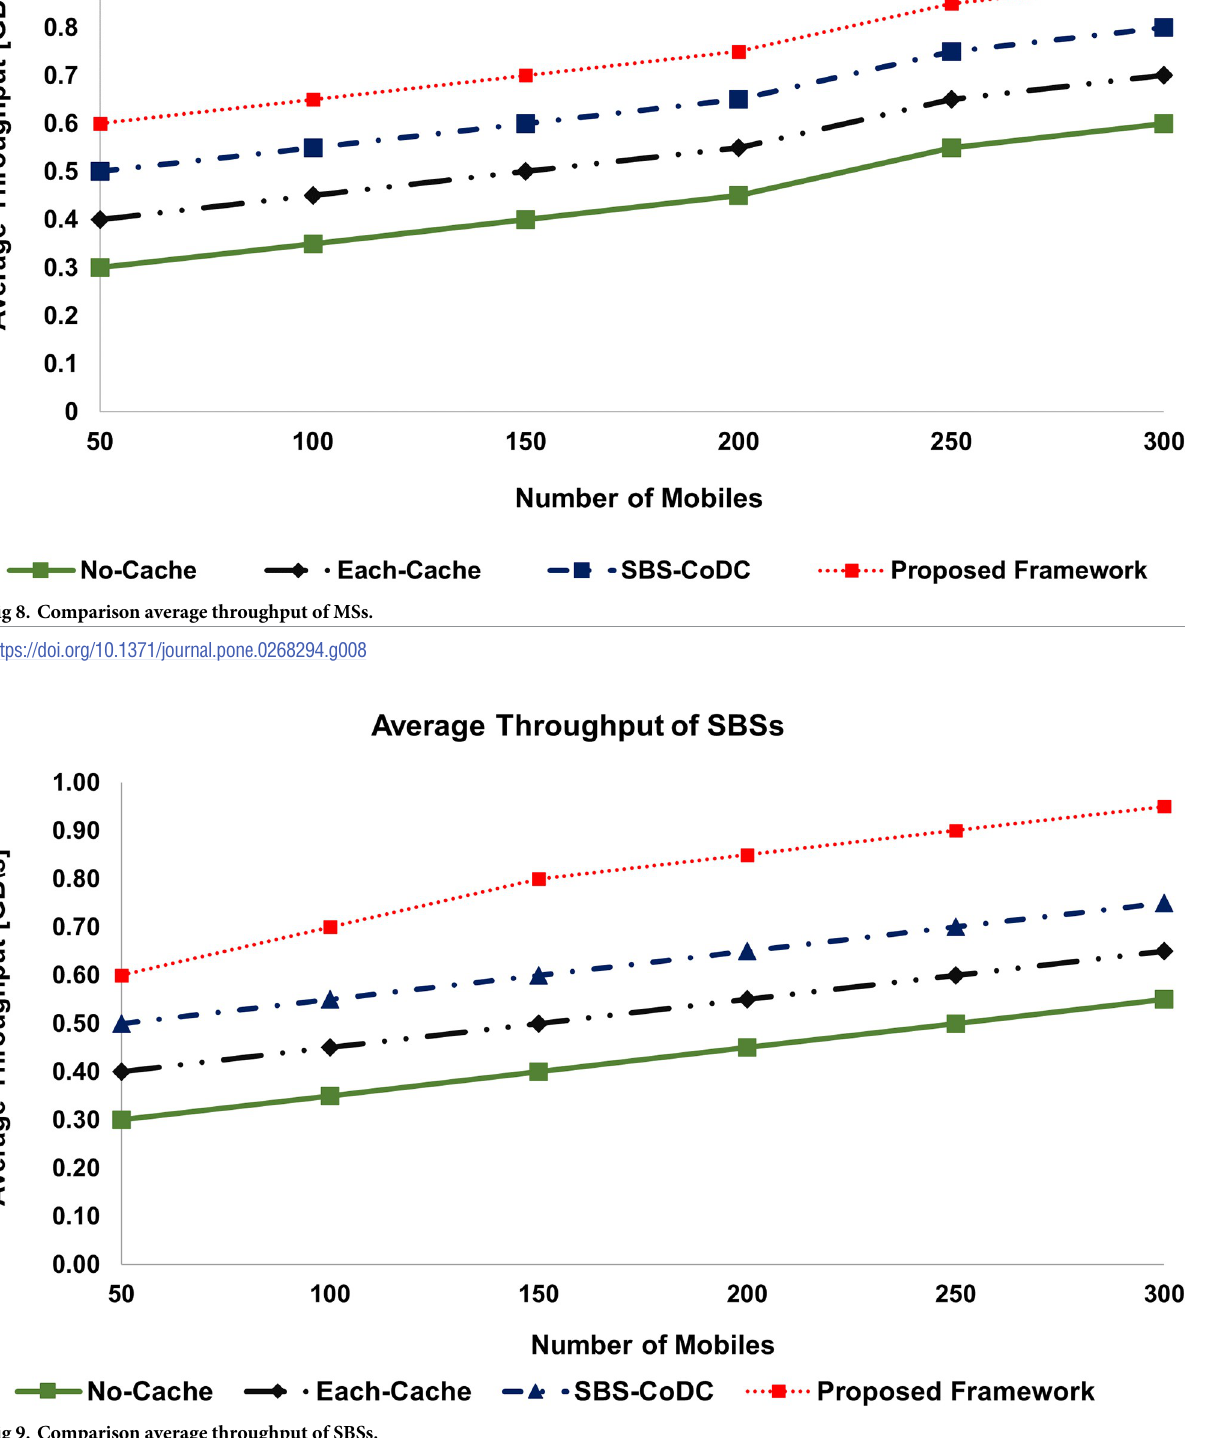
Fig 9. Comparison average throughput of